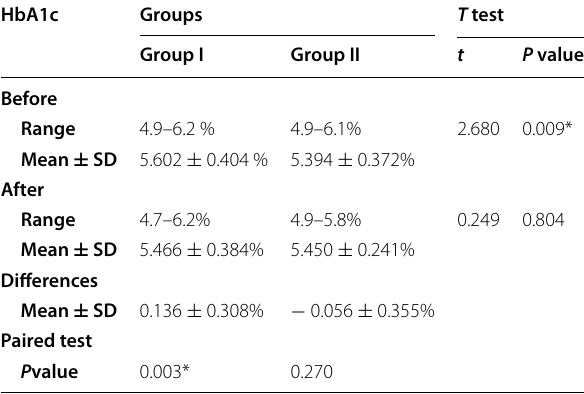
t Student’s t test, p p value for comparing between the two